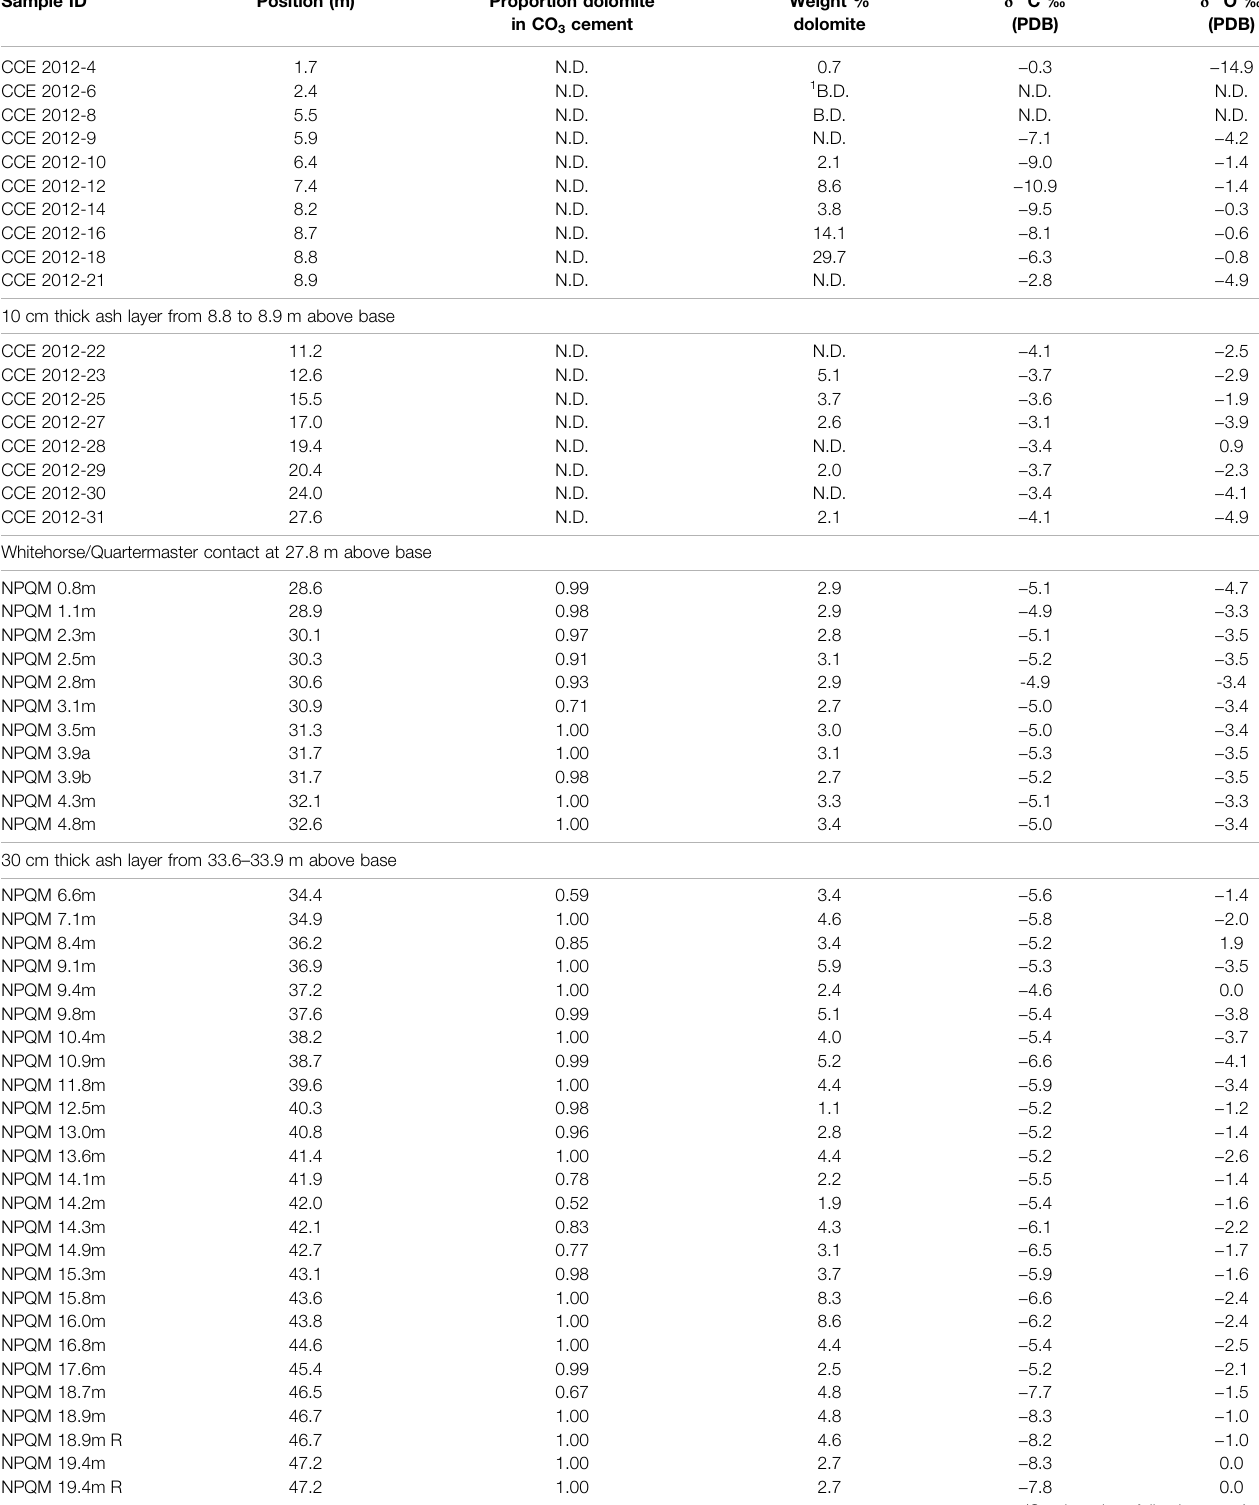
TABLE 9 | Results of analysis of dolomite cements from Caprock Canyons State Park. Sample ID